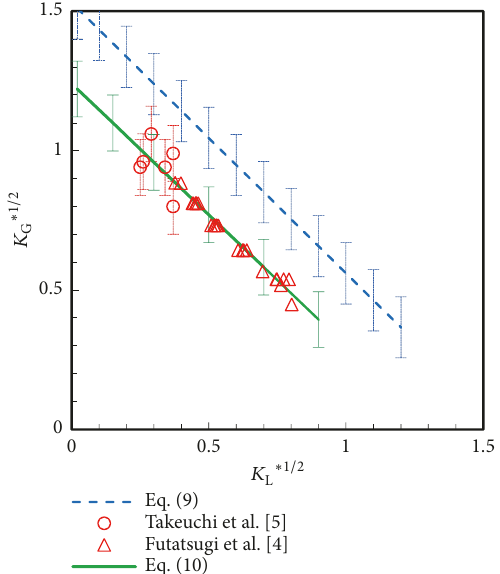
Figure 9: System characteristicsof CCFLin a pressurizer surge